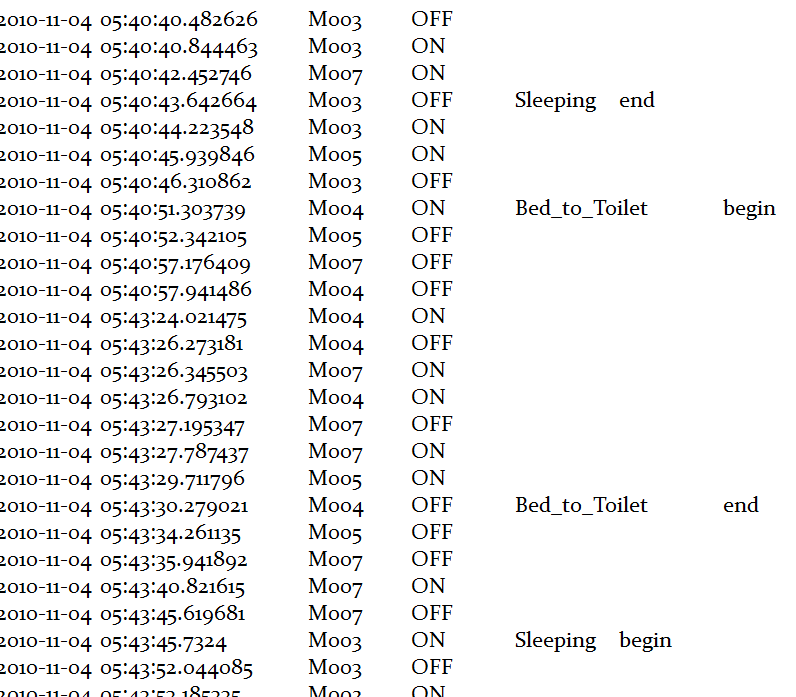
Figure 8. Sensor configuration of the dataset Aruba. Figure 9 represents an extract of the dataset with raw sensor data, where the annotated sensor events in the dataset include different categories of predefined activities of daily life, while the untagged sensor events are all labeled with “Other Activity”.